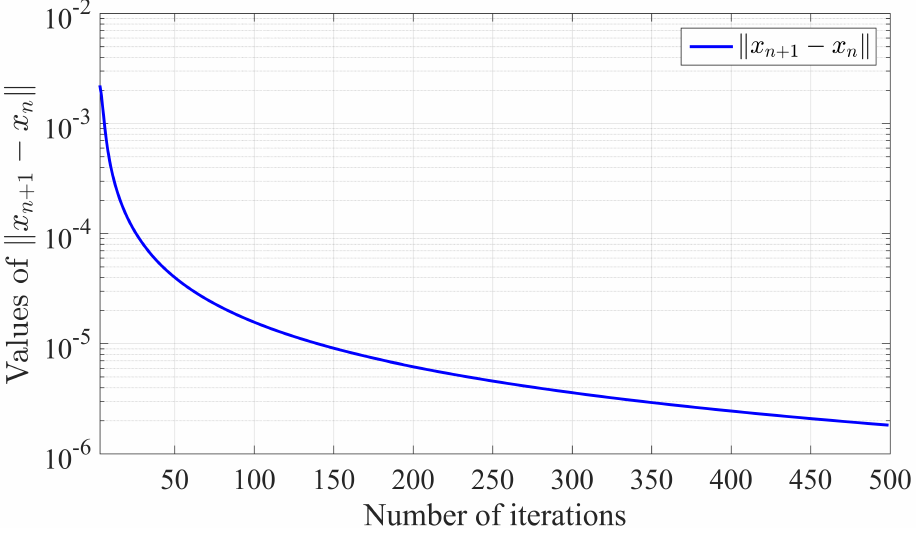
Figure 3. Plotting of (cid:107) x n + 1 − x n (cid:107)